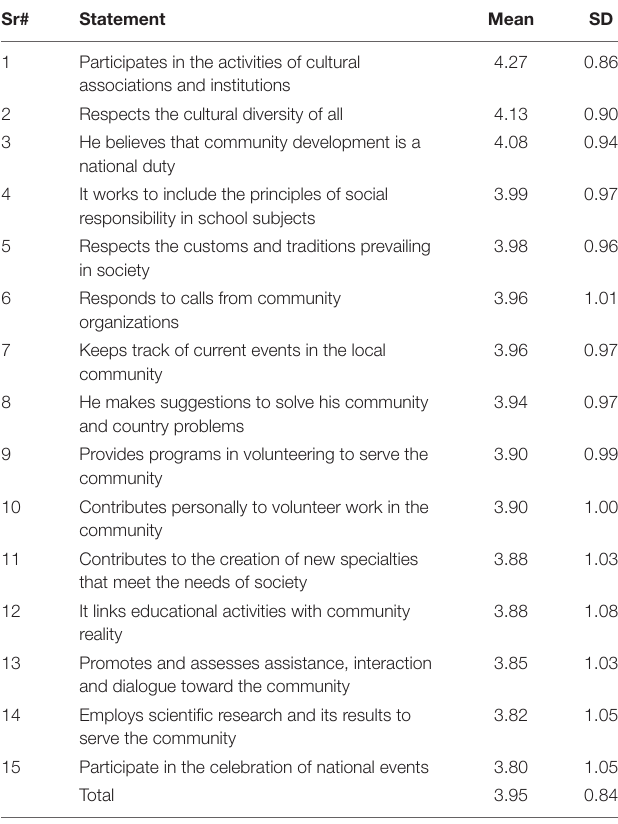
TABLE 5 | Social responsibility of faculty members toward society.